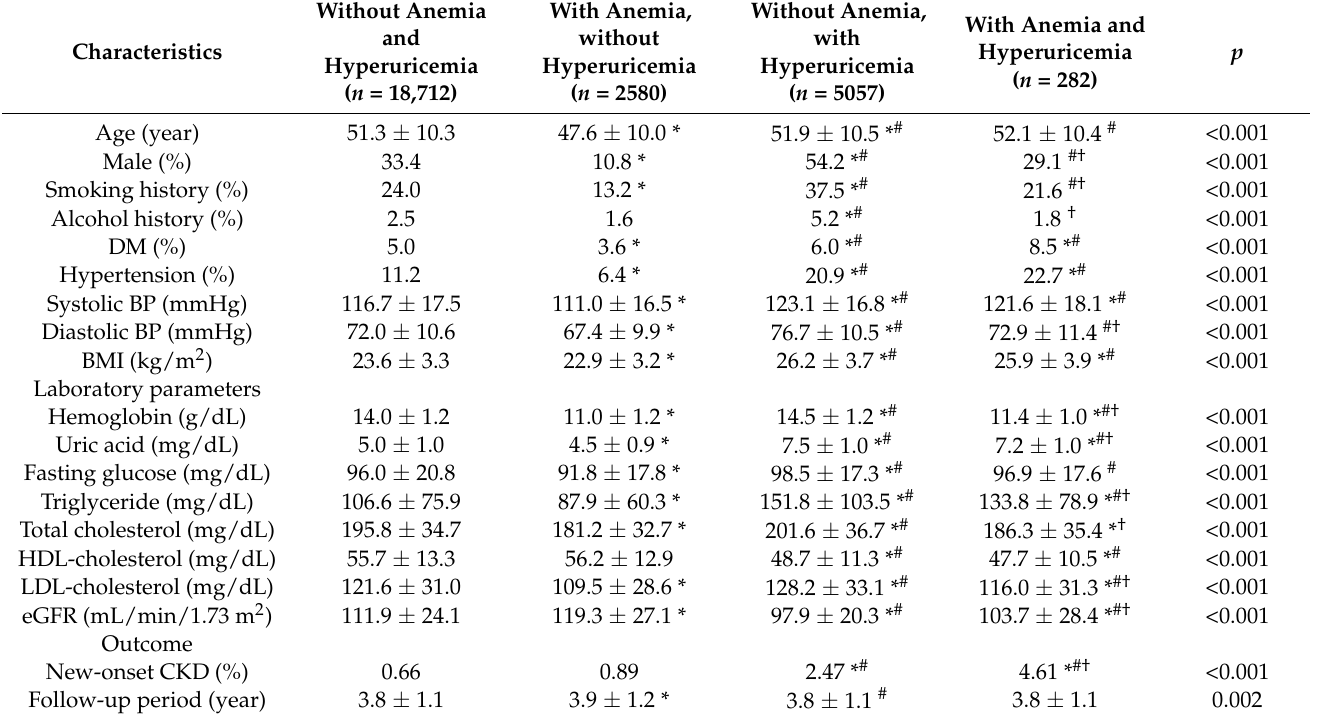
Table 1. Comparison of clinical characteristics among four study groups according to anemia and